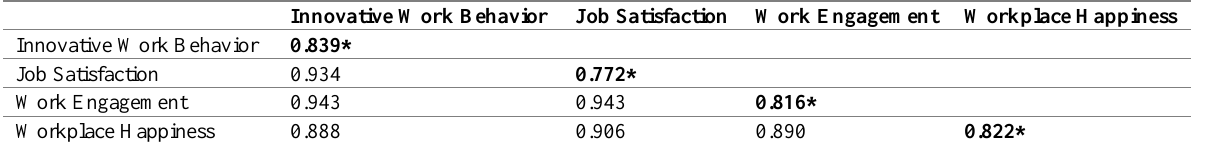
Table 2: Discriminant Validity